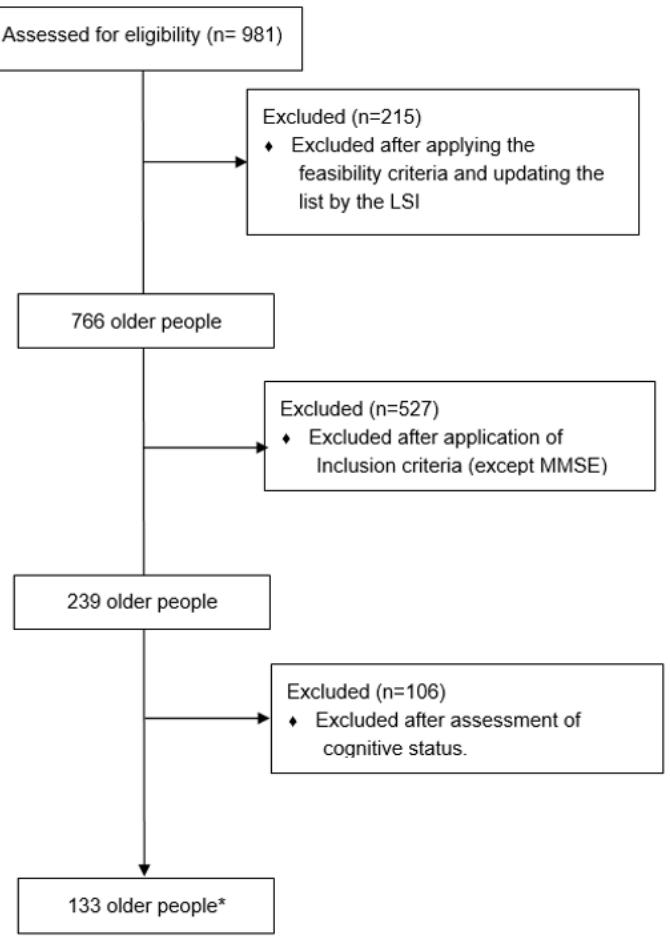
Figure 1. Sample selection flowchart for the study.